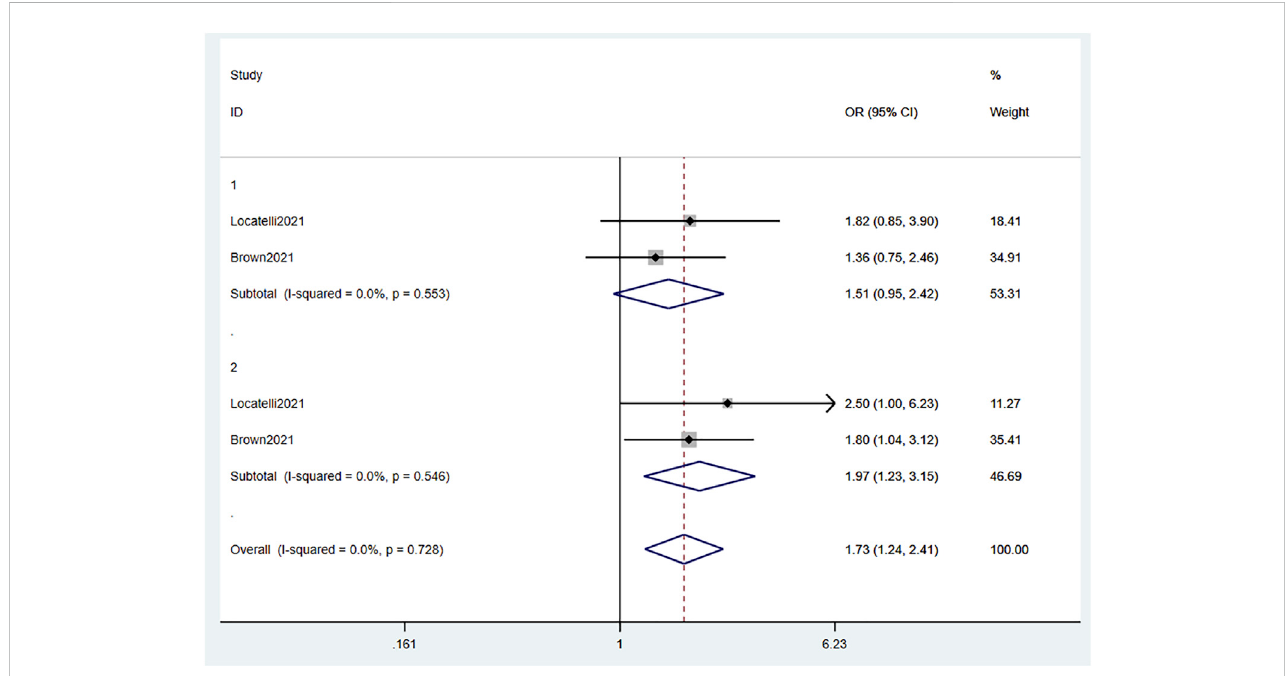
FIGURE 3 Forest plot of OS (RCTs). OS, overall survival; RCTs, randomized clinical trials; 95% CI, 95% con fi dence interval; OR: odds ratio; 1, 1-year; 2, 2-year. The size of the rectangle at the center of the horizontal bar is proportional to the weight of the given study. The diamond at the bottom indicates the pooled OR.